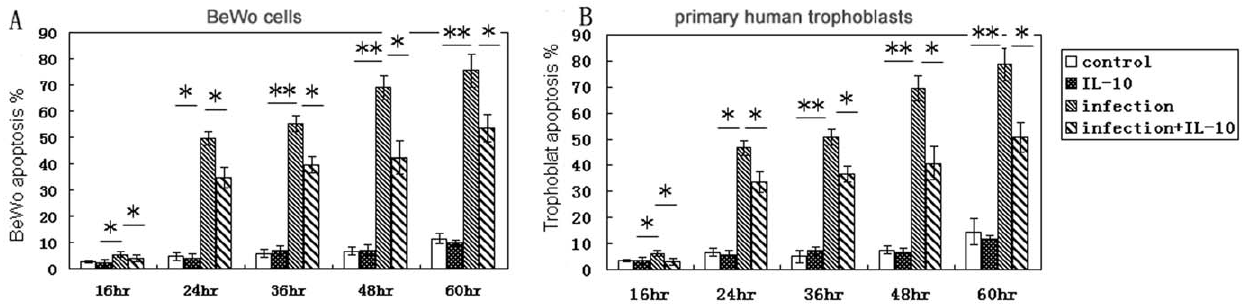
Figure 3. T.gondii infection induces apoptosis. Apoptotic cells were detected by flow cytometry after annexin V-PE/PI staining. PE + PI 2 and PE + PI + cells were defined as apoptotic. The percentage of apoptotic cells was lower in infected cells treated with IL-10 than in infected cells without IL-10 treated while there was no difference between uninfected cells and IL-10 treated uninfected cells. * p , 0.05, ** p , 0.01.